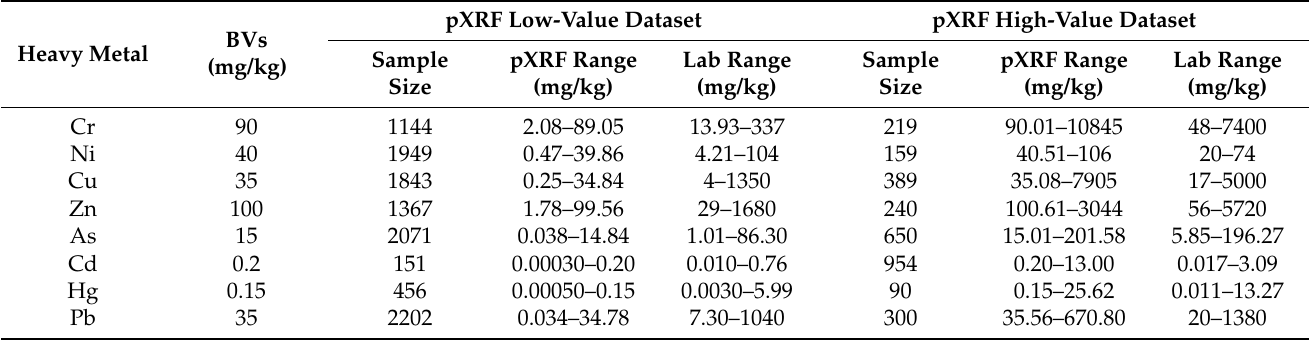
Table 3. Natural background value of each heavy metal and the concentration range of the two